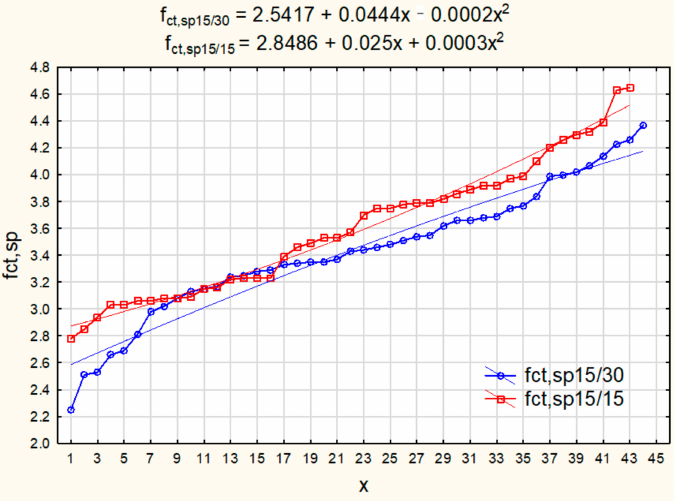
Figure 7. Line plots of variables f ct,sp15/30 and f ct15/15 for all test results, with the regression functions. The obtained MAPE was 2.8% for tensile strength of longer cylinders and 1.4% for ten- sile strength of short cylinders. It has been concluded that a good fit was obtained between the generated regression functions and the test data in both cases. The regression functions for longer and shorter cylinders described by Equations (4) and (5) were used to investigate the length effect. The Mean Percentage Error (MPE) was calculated (Equation (7)) in order to analyse the relation between predicted values of the variables f ct15/15 and f ct15/30